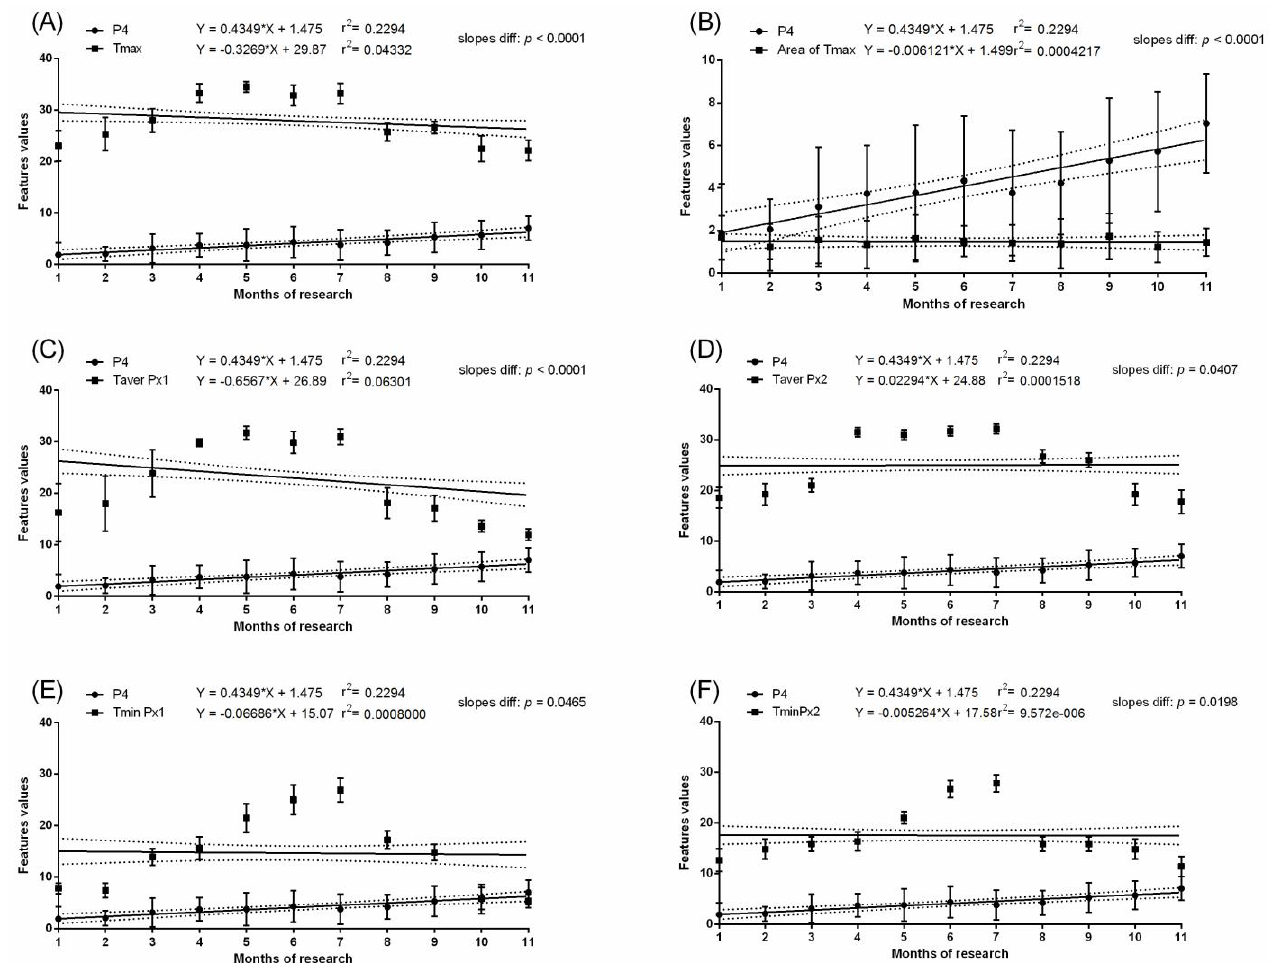
Figure 9. Linear regressions of progesterone concentration in the serum and selected thermal features of the lateral surface of the abdomen in non-pregnant mares: the maximal temperature in Px1 and Px2 ( A ); the area with the highest temperatures in the range of 3 ◦ C ( B ); the average temperature in Px1 ( C ); the average temperature in Px2 ( D ); the minimal temperature in Px1 ( E ); the minimal temperature in Px2 ( F ).